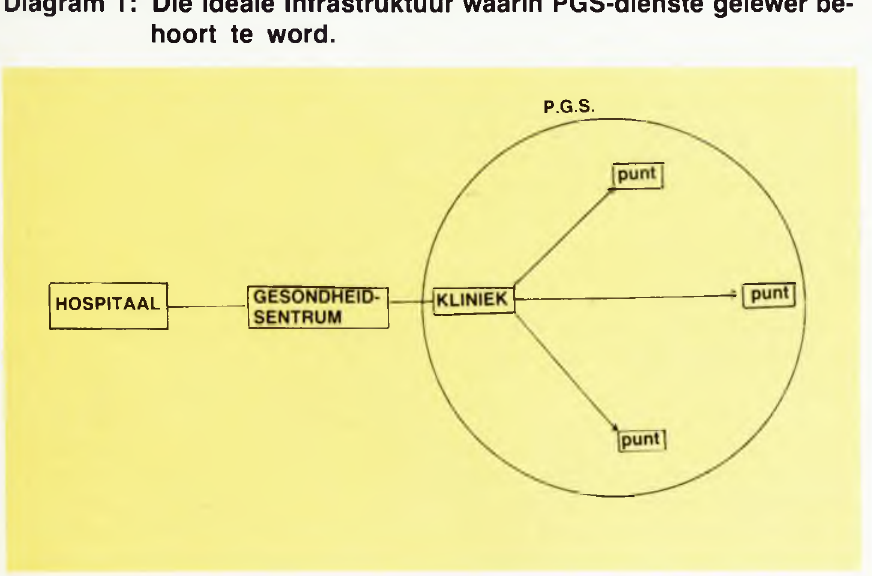
Diagram 1: Die Ideale Infrastruktuur waarin PGS-dienste gelewer be- hoort te